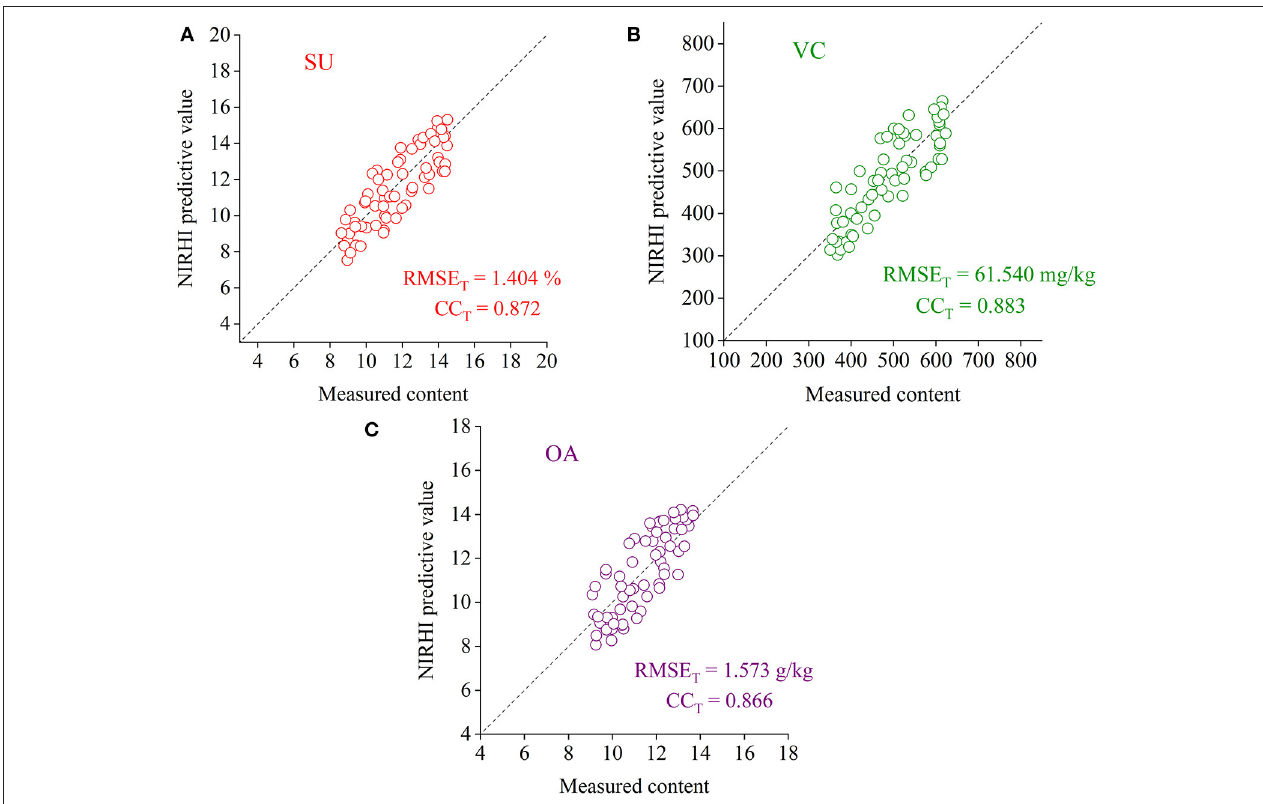
FIGURE 6 | The regression plots of the NIRHI predictions and the reference chemical measurements for the testing samples ( A–C are for the prediction of SU, VC, and OA,